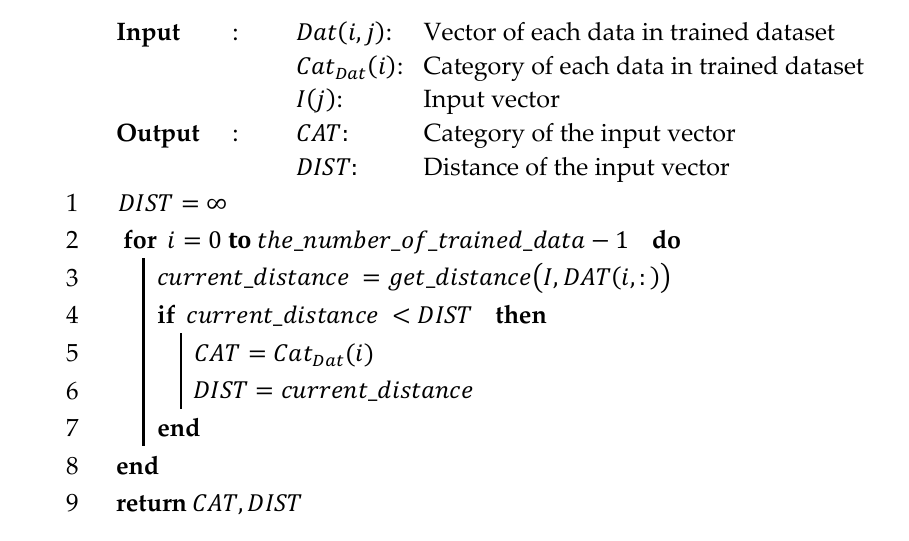
Algorithm 2: 1 -NN classification algorithm pseudo-code